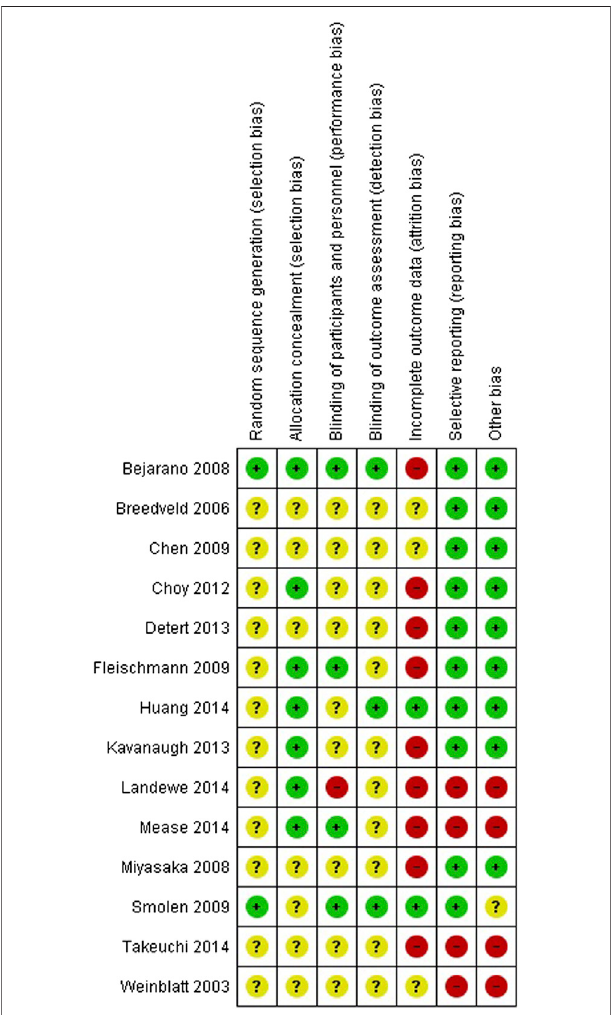
FIGURE 6 | Risk of bias summary for randomized controlled trials and prospective studies included in the meta-analysis (+): low risk of bias (+): high risk of bias (?): unclear risk of